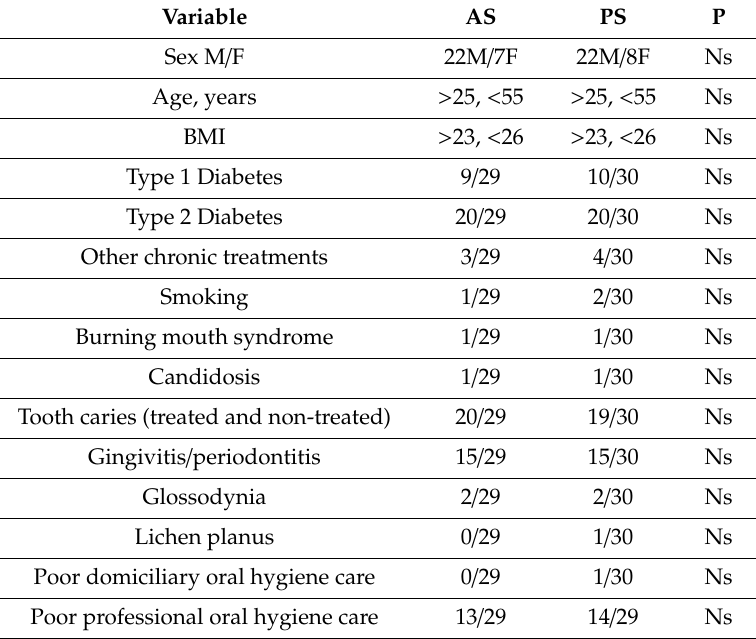
Table 2. Subjects characteristics: frequency of total cases or ranges with the relative statistical significance.